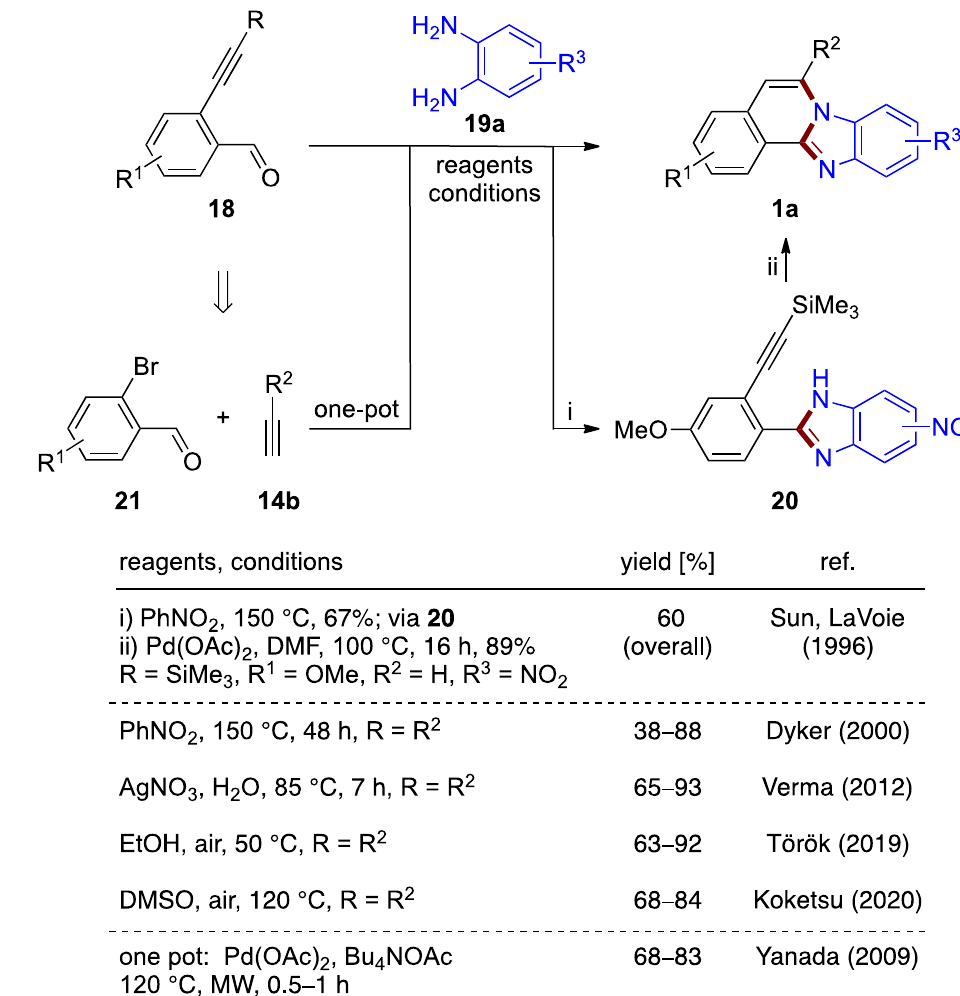
Figure 15. Synthesis of benzimidazo[2,1- a ]isoquinoline 1a by reaction of 2-ethynylbenzaldehyde 18 and o -phenylenediamine 19a (top) and by a one-pot reaction of bromobenzaldehydes 21 , terminal acetylenes 14b , and o -phenylenediamines 19a (bottom) [1,30,32–35].